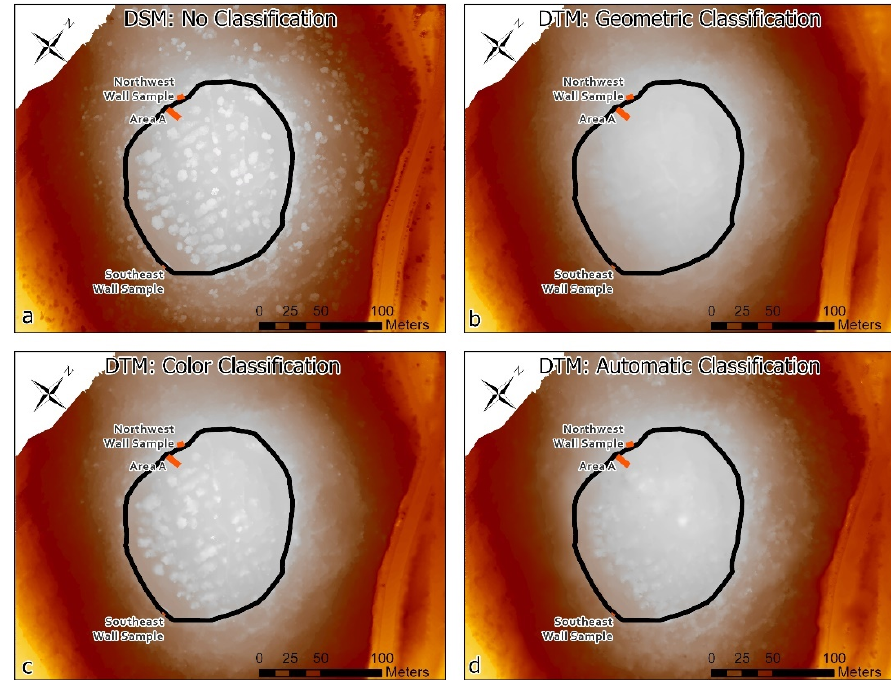
Figure 2. Comparison between an unmodified DEM of Kastrouli produced by ( a ) LAAP and pho- togrammetry and DTMs of the site generated by LAAP, photogrammetry, and point cloud classifi- cation through: ( b ) Classify Ground Points, ( c ) Select Points by Color, and ( d ) Classify Points. The site wall and excavation areas are shown for context. DEMs ( a , b ) are also viewable in interactive format here: https://storymaps.arcgis.com/stories/39280437536b4c458817fa4aa5c0b541 (accessed on 19 November 2021).